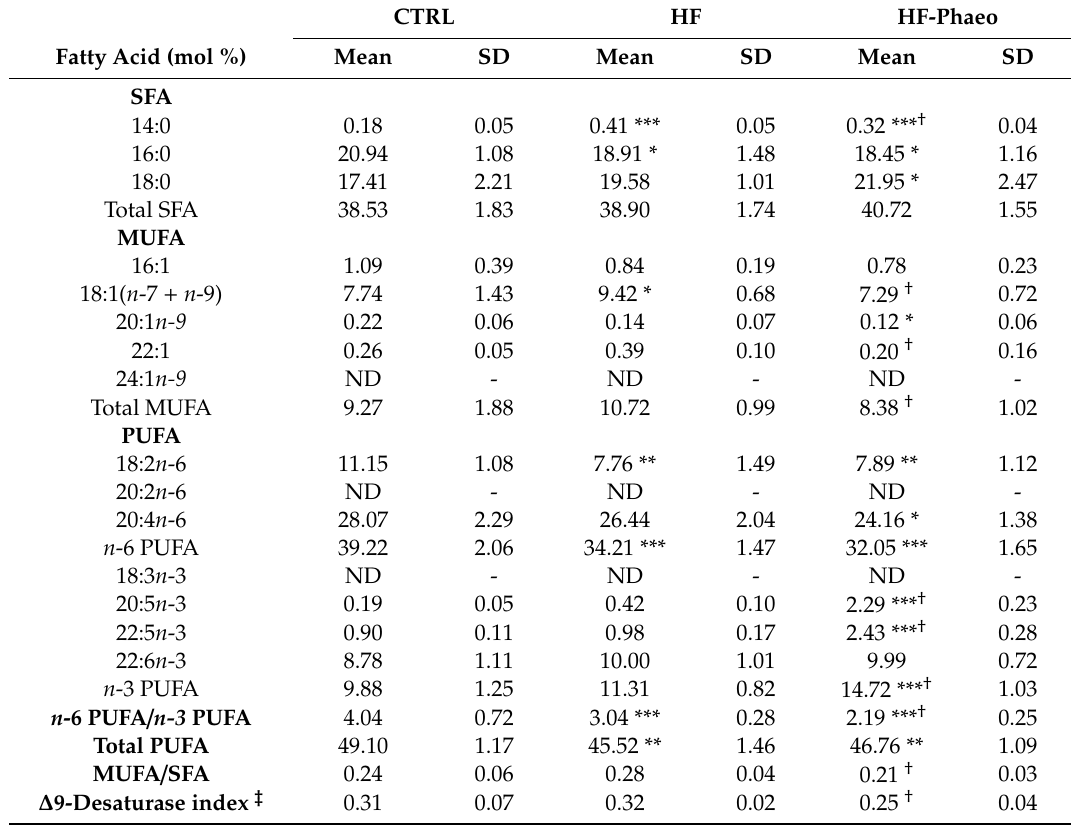
Table 4. Fatty acid composition of liver phospholipids.